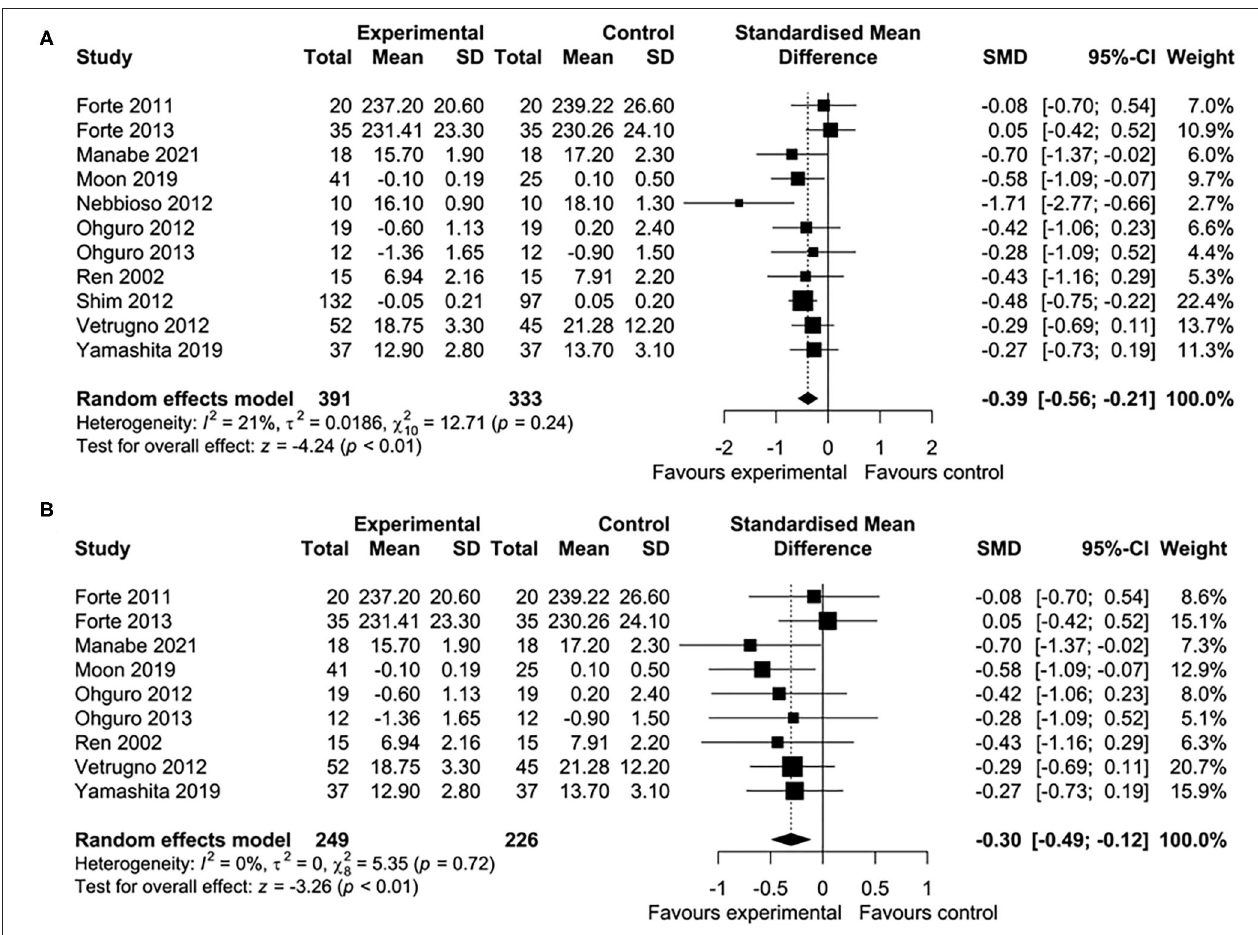
FIGURE 2 | Forest plots showing the effect of flavonoid supplementation on ophthalmic conditions. (A) Forest plot showing the effect of flavonoids in 10 clinical trials on ocular disorders. (B) Sensitivity analysis summarizing the effect of flavonoid supplementation on ocular disorders.